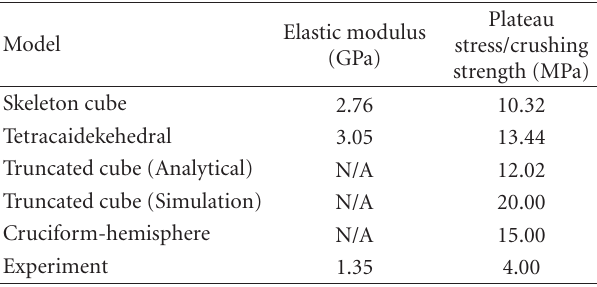
Table 1: Mechanical properties of a 12% relative density foam obtained from experiment and computation using existing foam